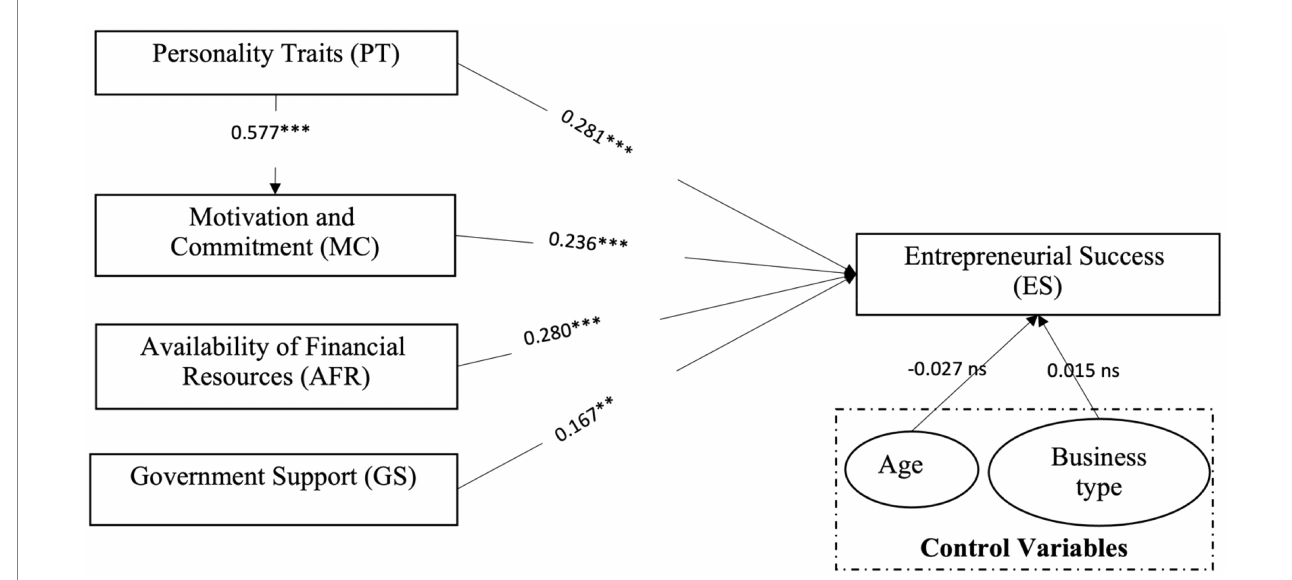
FIGURE 2 Structural model.